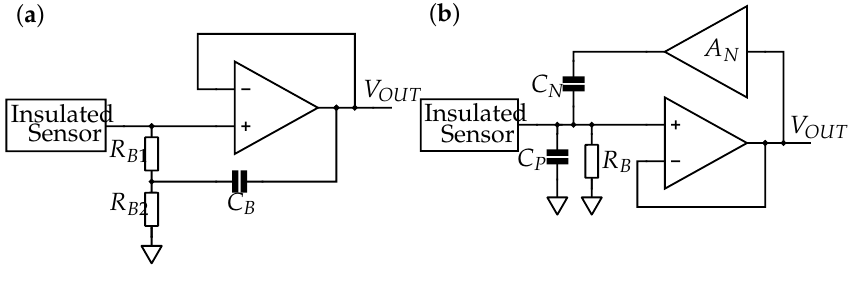
Figure 8. ( a ) Bootstrapping via C B to increase the input impedance while maintaining a DC path for the bias current. ( b ) Neutralization to reduce parasitic capacity C P . A N is the gain to be set for the feedback loop via C N . Adapted from